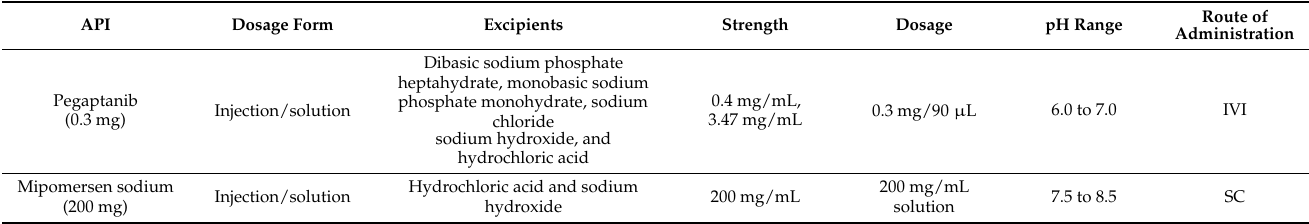
Table 2. In brief therapeutic information of approved nucleic acid (NA)